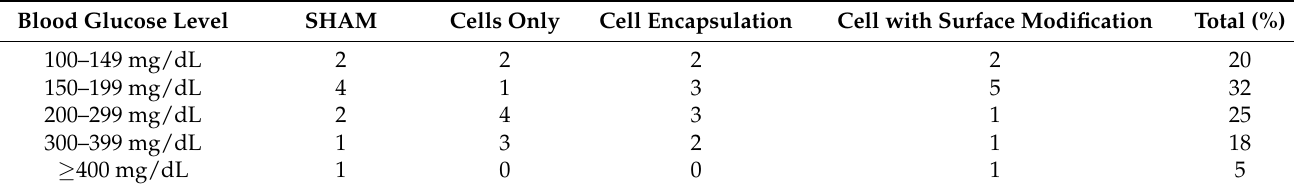
Table 1. Blood glucose levels of mice at 14 days after STZ induction and before transplantation. Blood Glucose Level SHAM Cells Only Cell Encapsulation Cell with Surface Modification Total